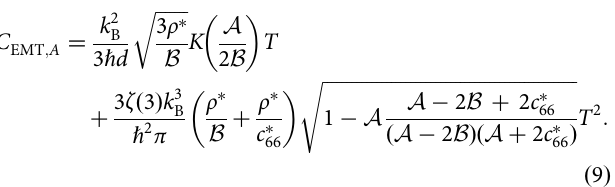
The fi rst T -linear part of the formula corresponds to the antisymmetric mode, while the quadratic part contains the contributions of the shear and symmetric modes. In the quadratic part we see two terms proportional to ρ (cid:1) = B and ρ (cid:1) = c (cid:1) resemble and converge to the full plate isotropic (inverse) wave and c (cid:3) 2 , respectively, in the zero fi lling factor limit. It is speeds c (cid:3) 2 S SH then clear that in the f → 0 limit the above formula reduces to the previously reported analytical results for the full isotropic plates 25 .